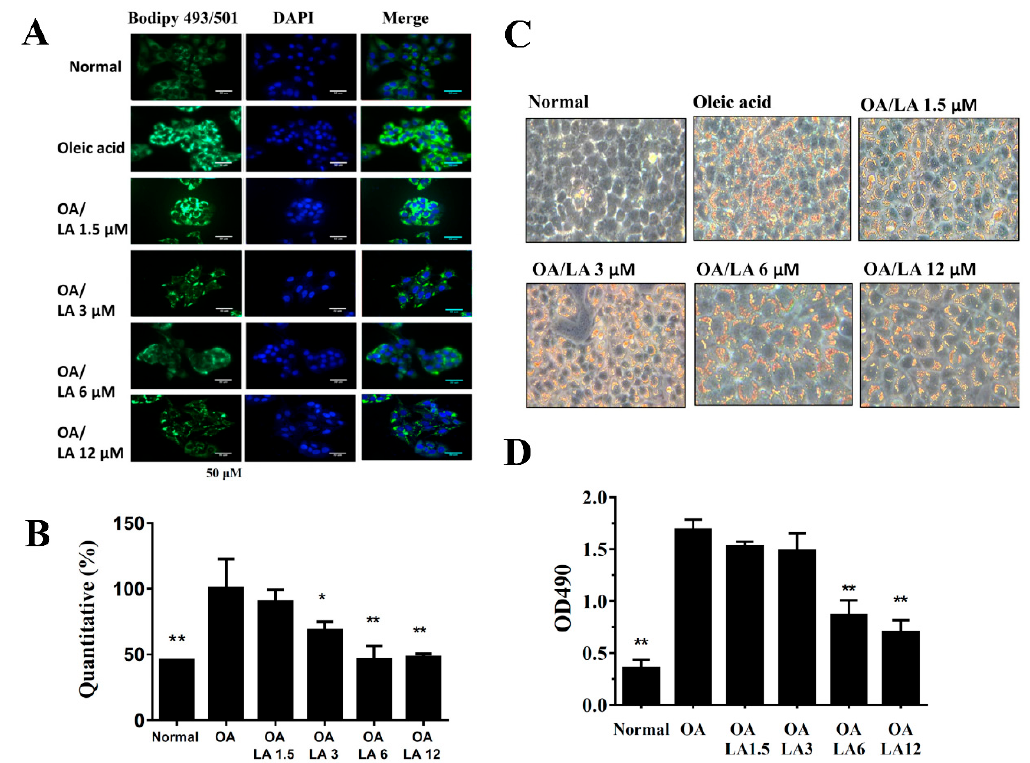
Figure 7. Licochalcone A (LA) reduced lipid accumulation in HepG2 cells. HepG2 cells were treated with 0.5 mM oleic acid (OA) at 37 ◦ C for 48 h to induce lipid accumulation in hepatocytes, followed by treatment with licochalcone A (1.5–12 µ M) for 24 h. ( A ) The fluorescent dye BODIPY 493 / 503 (green) was used to detect hepatic lipid droplets using a fluorescent microscope. Three independent experiments were analyzed. Nuclei were stained with DAPI (blue), and ( B ) Fluorescent images were quantified. ( C ) Oil red O staining showed lipid accumulation. ( D ) HepG2 cells treated with isopropanol and lipid accumulation measured using the absorbance at OD 490 nm. Three independent experiments were analyzed. The data are presented as the mean ± SEM; * p < 0.05, ** p < 0.01 compared with oleic acid-induced HepG2 cells.